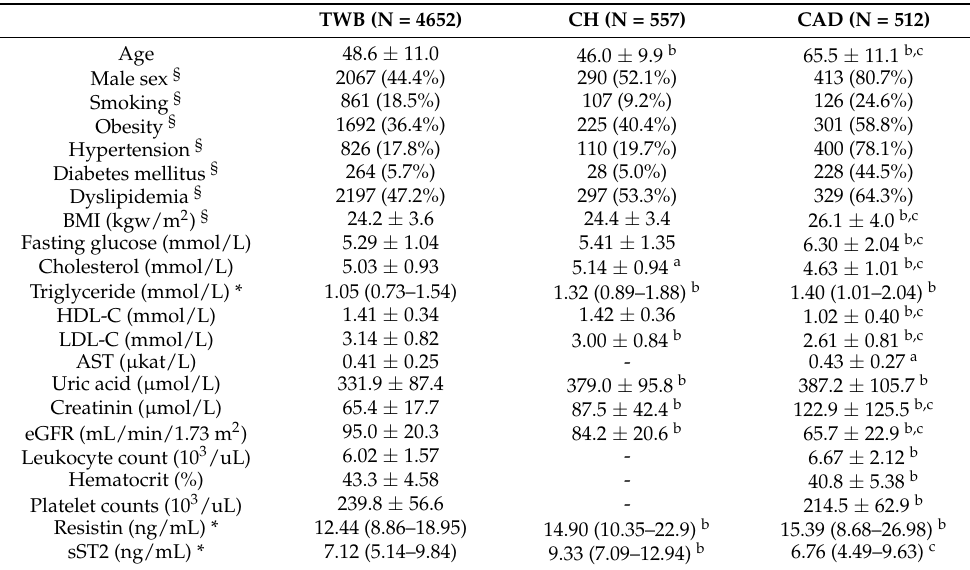
Table 2. Baseline characteristics between TWB, CH, and CAD